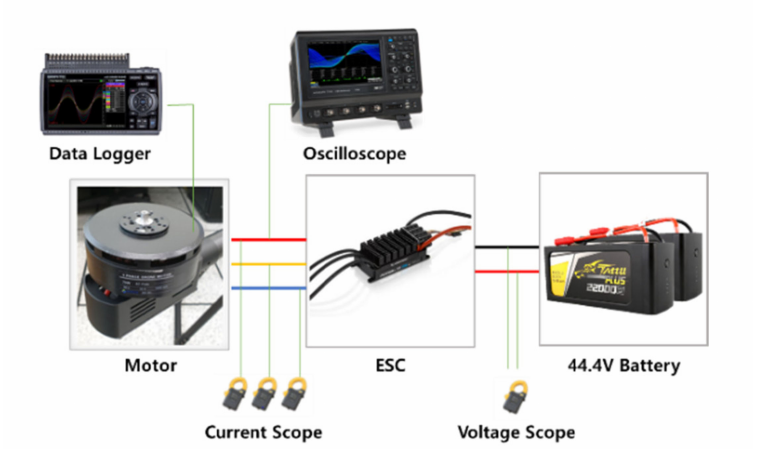
Figure 8. Configuration of the UAV motor heat dissipation characteristics experiment.